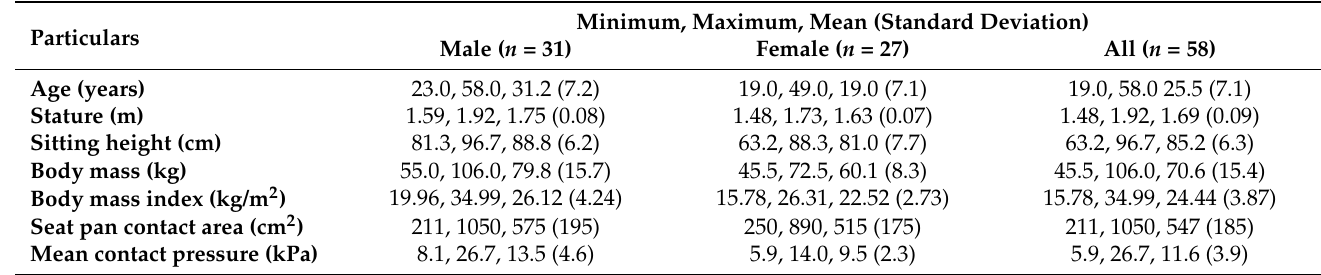
Table 1. Range (minima, maxima, means and standard deviations) of anthropometric dimensions of the